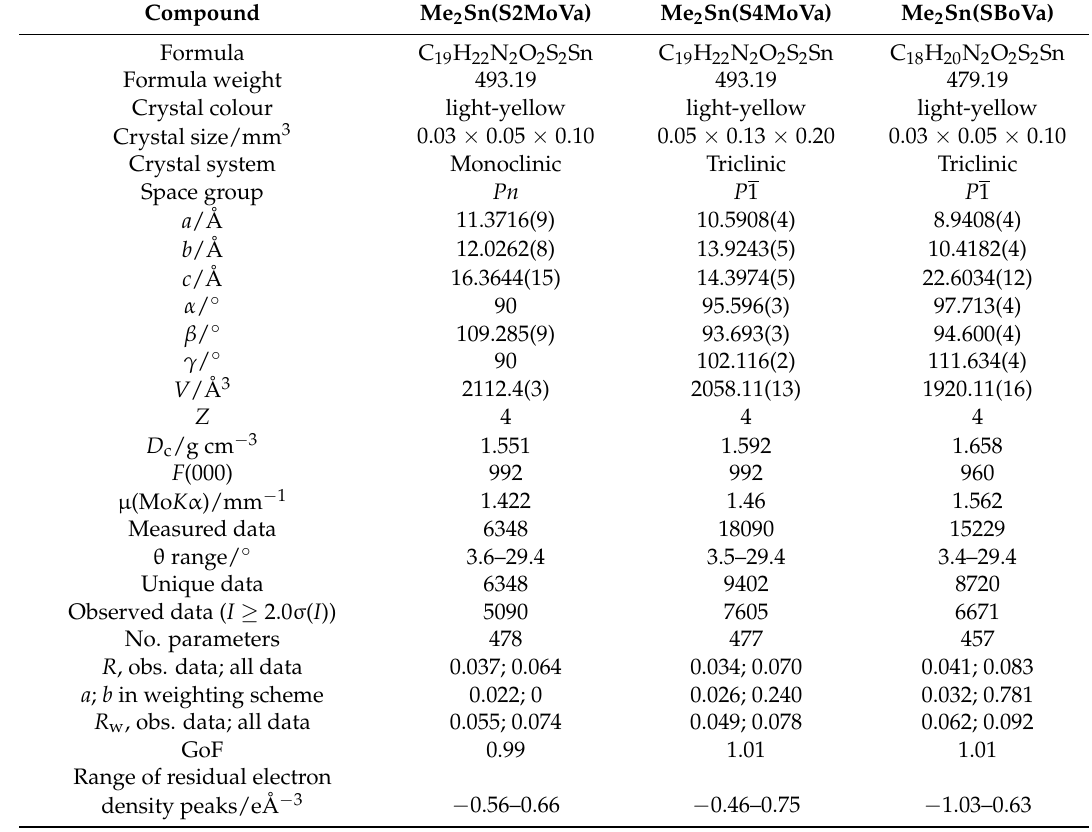
Table 5. Crystal data and refinement details for compounds Me 2 Sn(S2MoVa), Me 2 Sn(S4MoVa) and Me 2